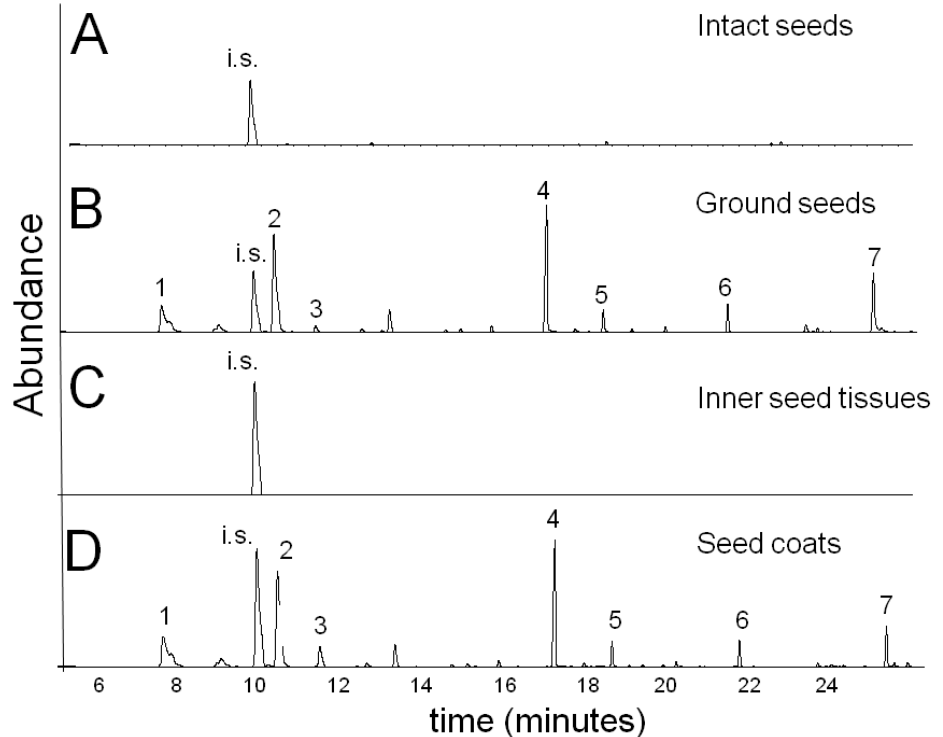
Figure 4. Distribution of mono-and sesquiterpene volatiles in N. sativa mature seed. The volatiles were solvent extracted and analyzed by GC-MS as described in Materials and Methods. 1 : α-thujene; 2 : p -cymene; 3 : γ-terpinene; 4 : thymoquinone; 5 : carvacrol; 6 : longifolene; 7 : thymohydroquinone; i.s. internal standard (isobutyl benzene). ( A ) Mature intact seed. ( B ) Ground complete seed. ( C ) Inner seed tissues (endosperm and embryo). ( D ) Seed